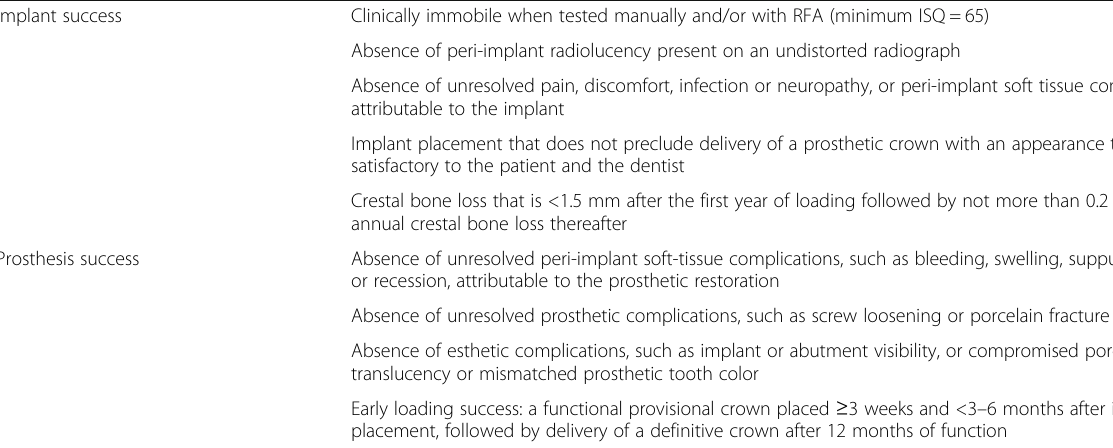
Table 2 Outcome success criteria Implant